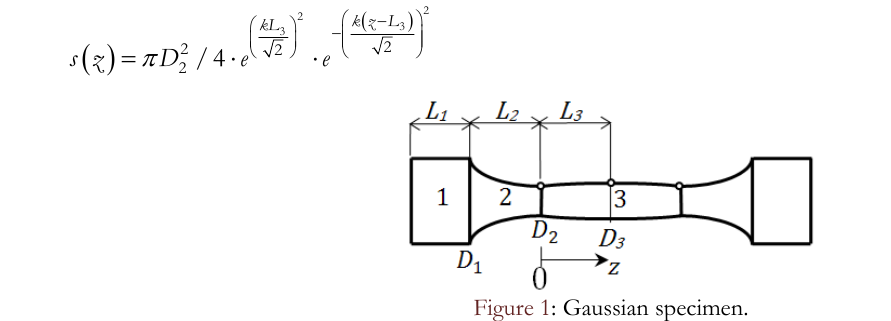
Figure 1: Gaussian